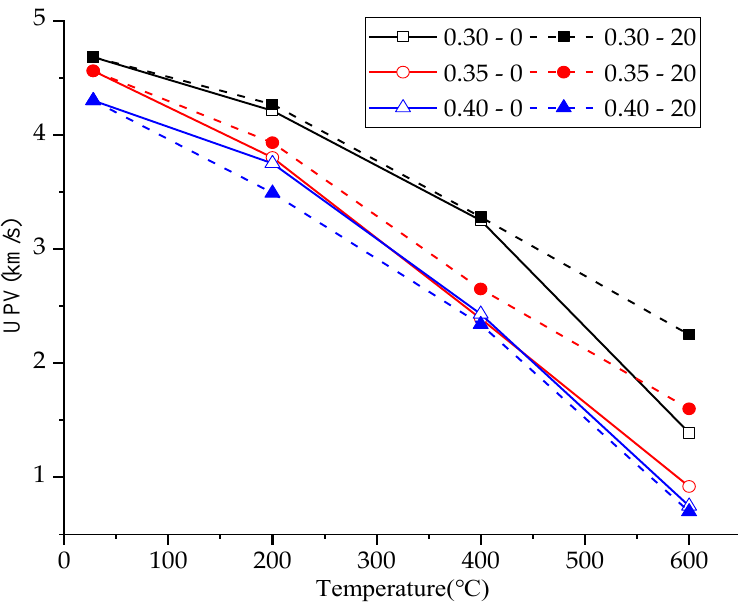
Figure 2. Ultrasonic pulse velocity of